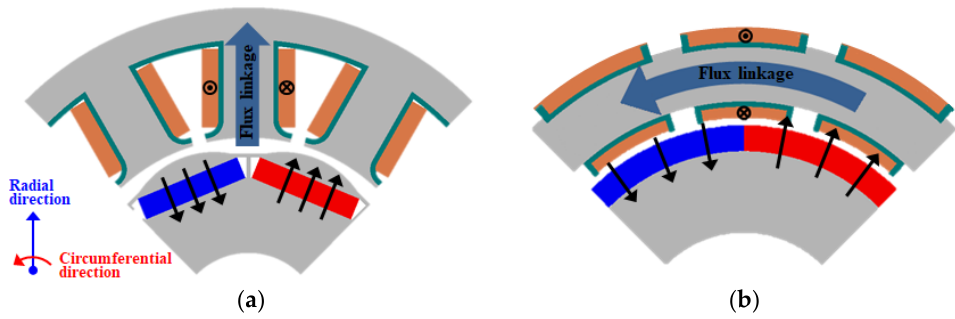
Figure 2. Direction of flux linkage: ( a ) Conventional motor, and ( b ) Slotless motor with toroidal winding.